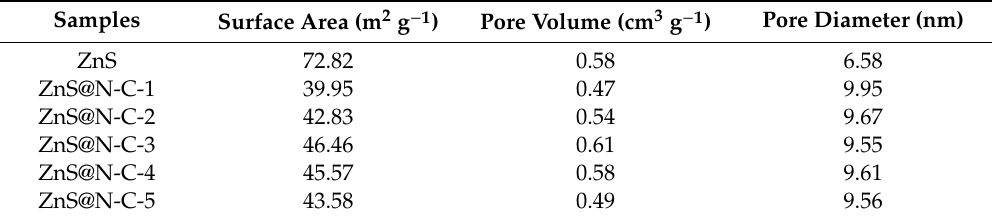
Figure 1. XRD patterns of ZnS and N-doped carbon-coated ZnS with a sulfur-vacancy defect (ZnS@N-C) composites. Table 1. Surface parameters of ZnS and ZnS@N-C